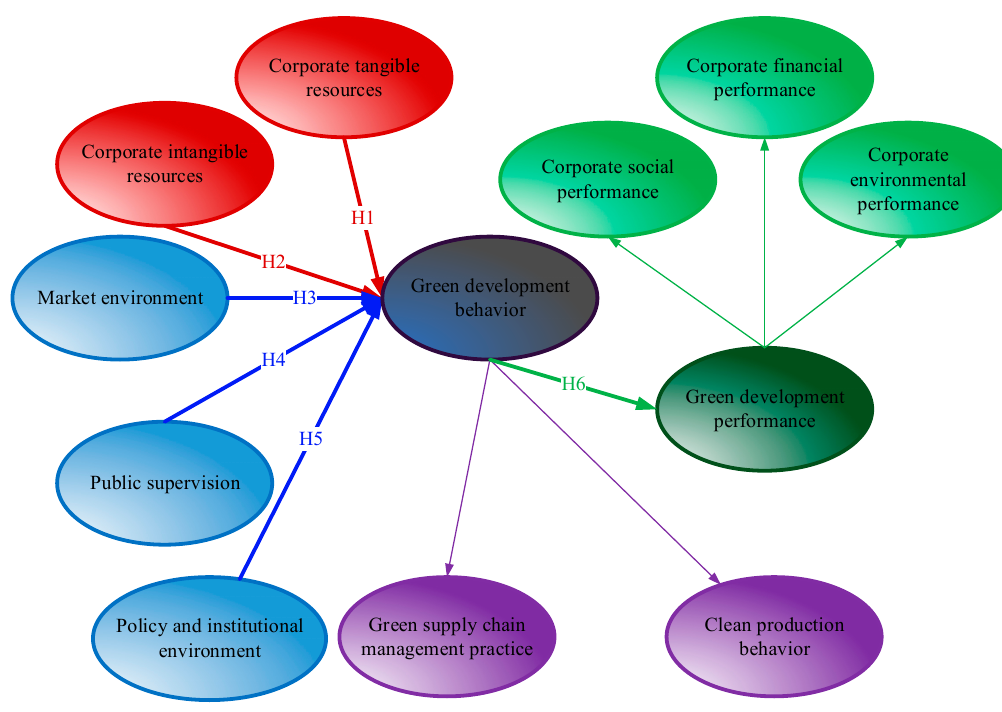
Figure 1. The green development behavior and performance of industrial enterprises (GDBP-IE) hypothetical model.